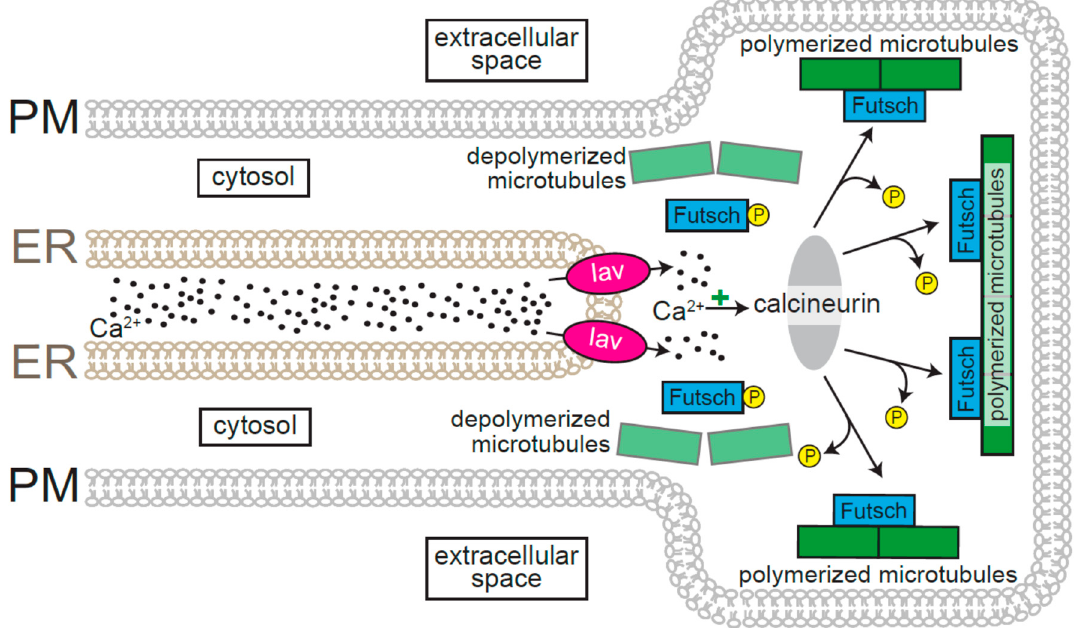
Figure 1. Schematic depicting the role of the ER Ca 2+ channel, Inactive (Iav), in the formation of Drosophila presynaptic boutons. Within the Drosophila neuromuscular junction, presynaptic boutons morphology and number are regulated by stabilized microtubules. Phosphorylated Futsch cannot bind to microtubules, leading to microtubule destabilization. The Ca 2+ -dependent phosphatase, calcineurin, is activated by Ca 2+ released by Iav and subsequently dephosphorylates Futsch, which leads to microtubule stabilization.